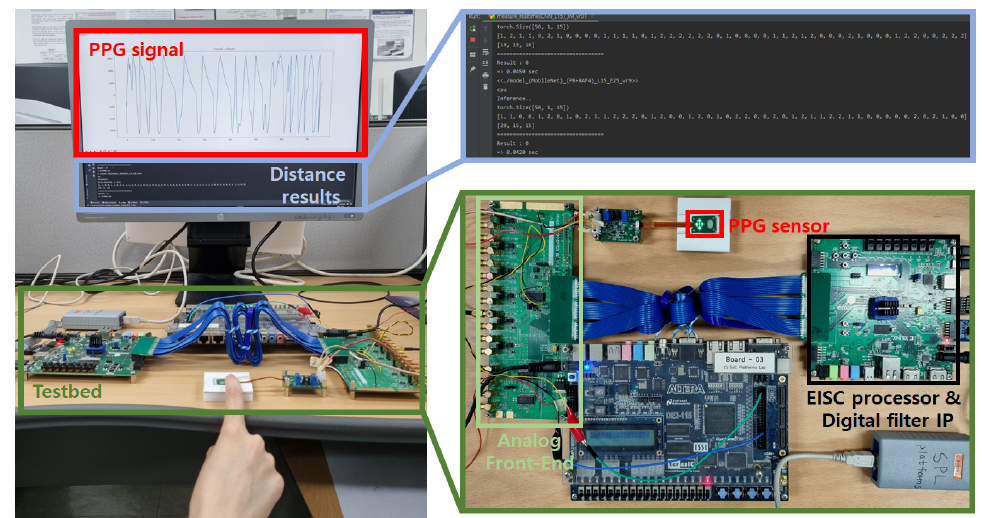
Figure 7. Experimental